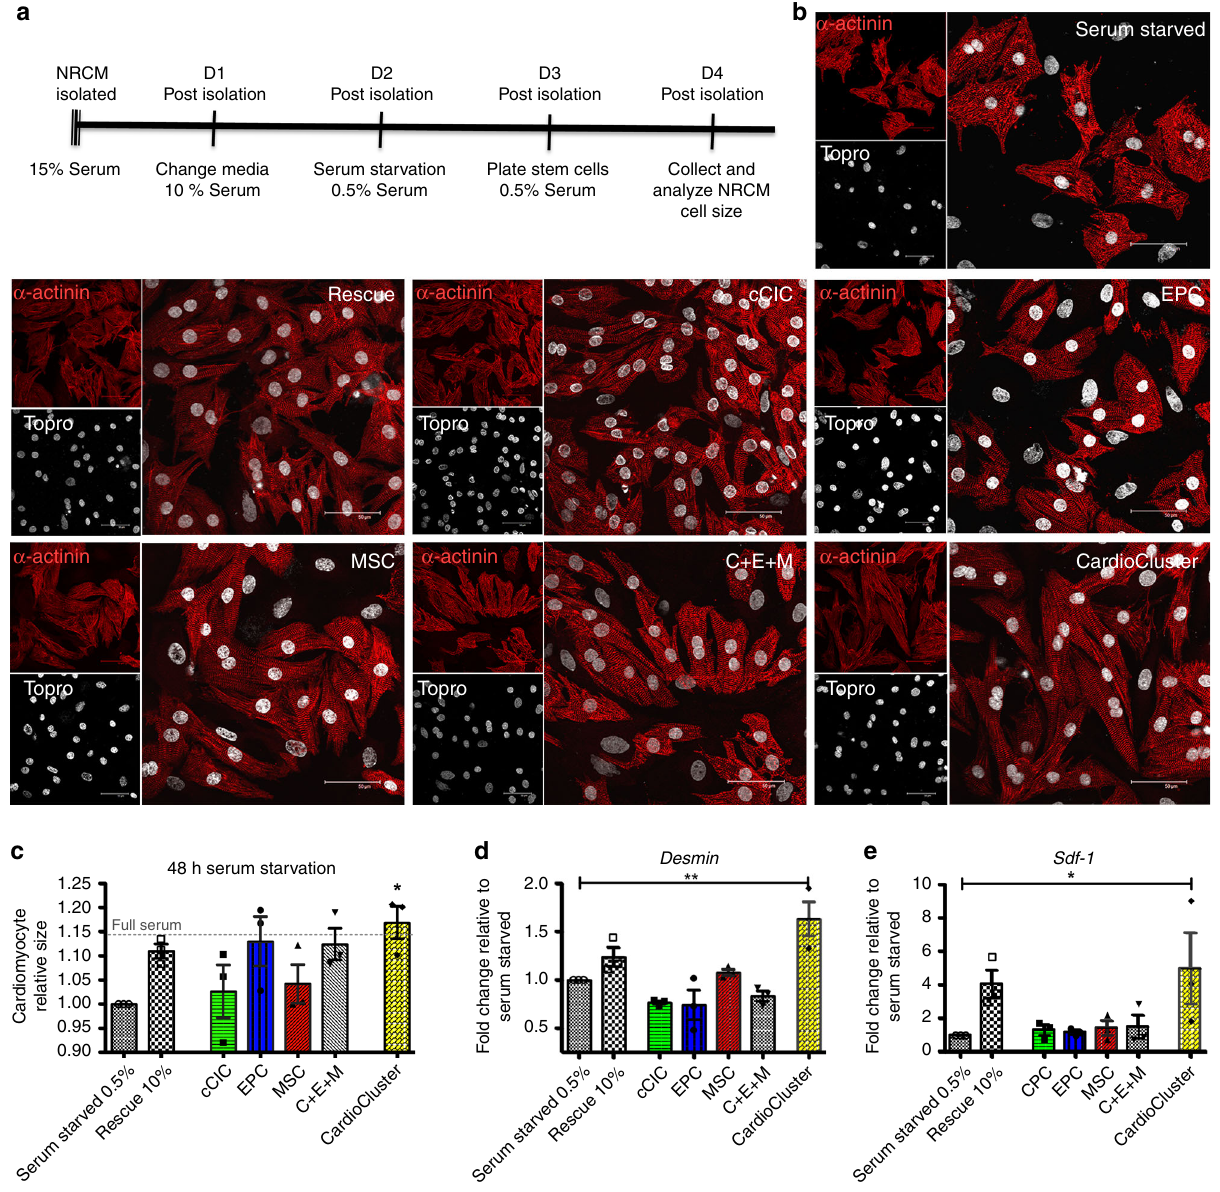
Fig. 2 CardioClusters protect cardiomyocytes against low serum conditions in vitro. a Timeline for neonatal rat cardiomyocyte (NRCM) low serum assay over a 4-day (D) period. b Representative images of NRCM conditions: serum starved (48 h of 0.5% serum), rescued (24 h of 0.5% serum with 10% serum added for additional 24 h), and experimental groups (24 h of 0.5% serum with addition of either cCIC, EPC, MSC, C + E + M, or CardioCluster for additional 24 h). Cardiomyocytes visualized by staining with sarcomeric actinin ( α -actinin; red). TO-PRO-3 iodide (Topro; white) used to visualize nuclei. Scale bar, 50 µ m. c Quantitation of cardiomyocyte size relative to serum starved control. d , e Gene expression of desmin ( d ) and sdf-1 ( e ) in cardiomyocytes with and without the addition of cells. Data in c – e represent mean ( n = 3 independent NRCM preparations) ± SEM. Data are presented as one-way ANOVA with Dunnett ’ s comparison test, c * p = 0.028, d **p = 0.003, e * p = 0.038, versus serum starved. Source data are provided as a Source data fi